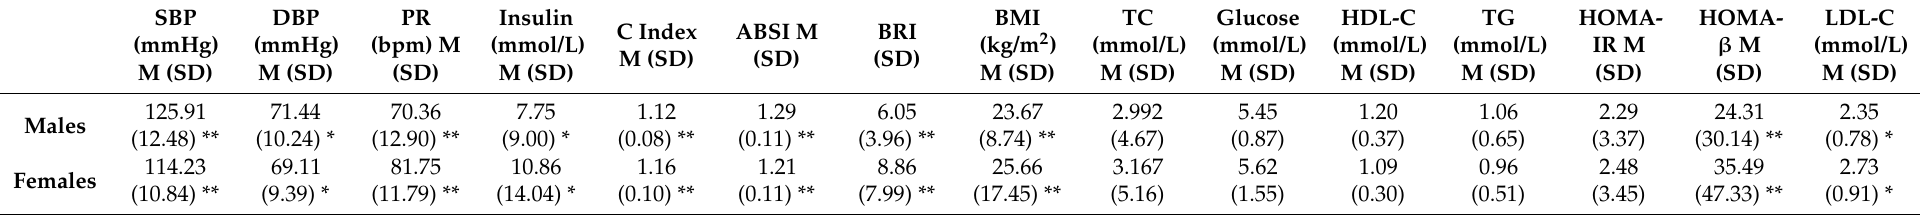
Table 1. Descriptive statistics of anthropometric indices, blood pressure, and biochemical measurements of Ellisras young adults aged 21–30